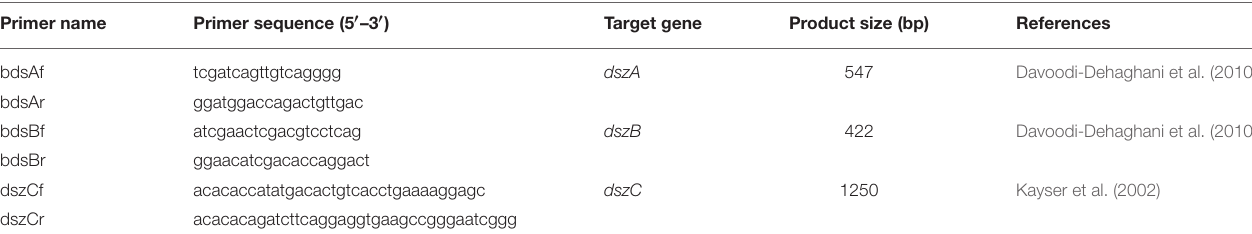
TABLE 1 | Primers used in this